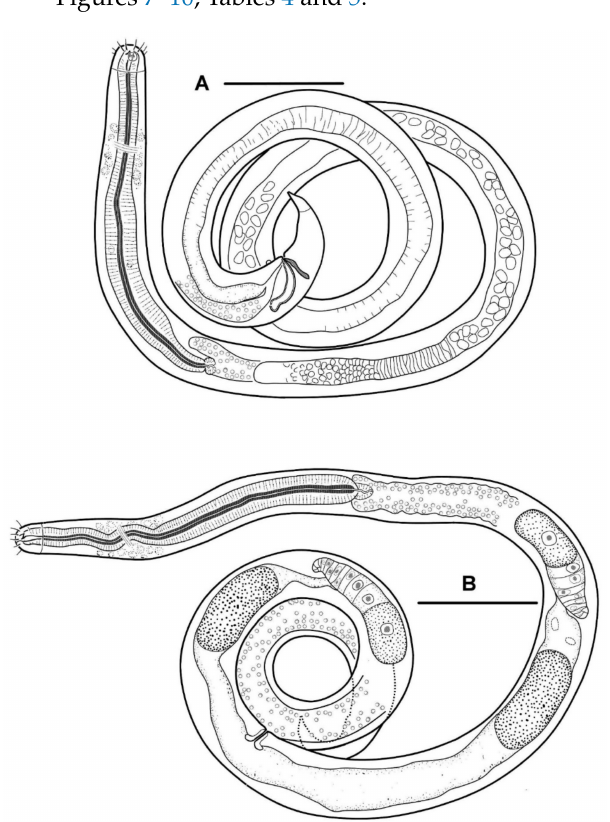
Figure 7. Acanthopharynx micans , entire (sample PA13, sponge Cinachry a sp.): ( A )—male. ( B )—female. Scale bars 100 µ